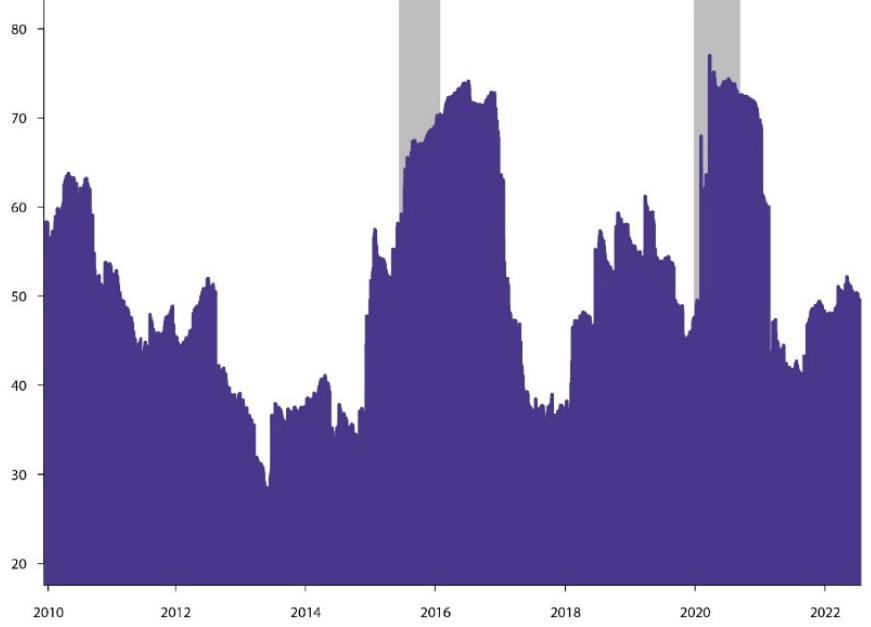
Figure 2. Total volatility spillover.